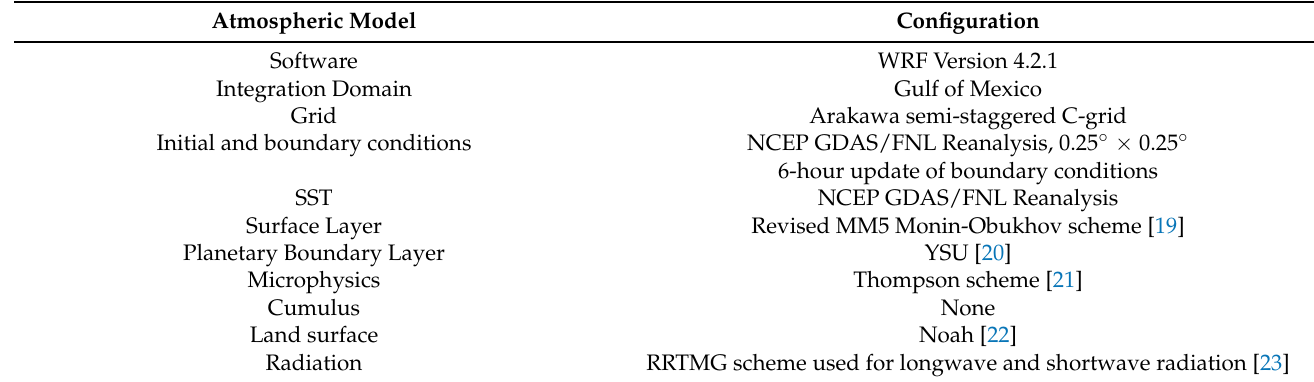
Table 1. A list of the key physics schemes and meteorological data sources that are used in this